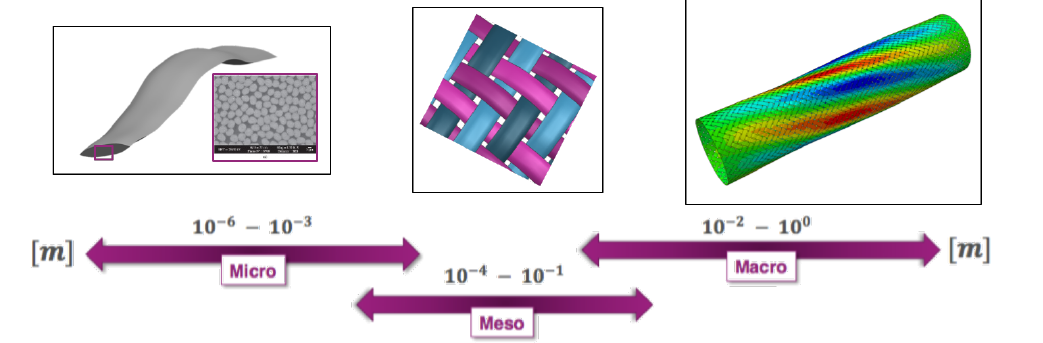
Figure 1. Structural levels of a textile composite. (adapted from [2])